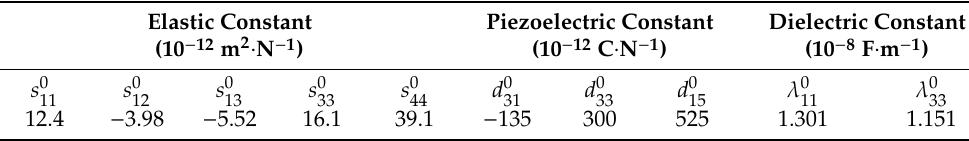
Table 1. Physical properties of PZT-4 materials [32].